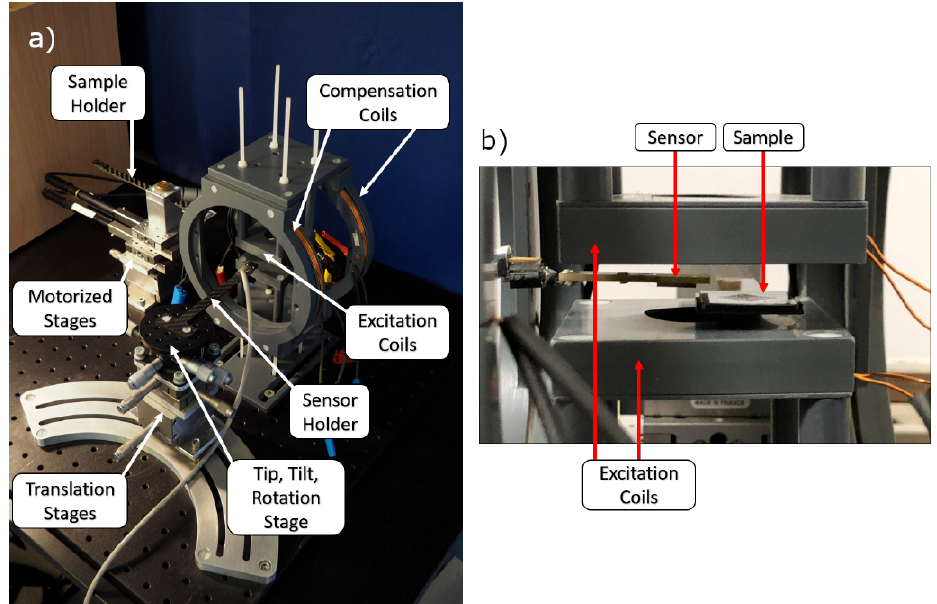
Figure 5. ( a ) Experimental Magnetic Particle Mapping setup. Manual tip, tilt, rotation and translation stage are used to position the sensor with high precision. Motorized stages are used to move the sample with respect to the sensor. ( b ) Close-Up of sensor near the sample between the excitation